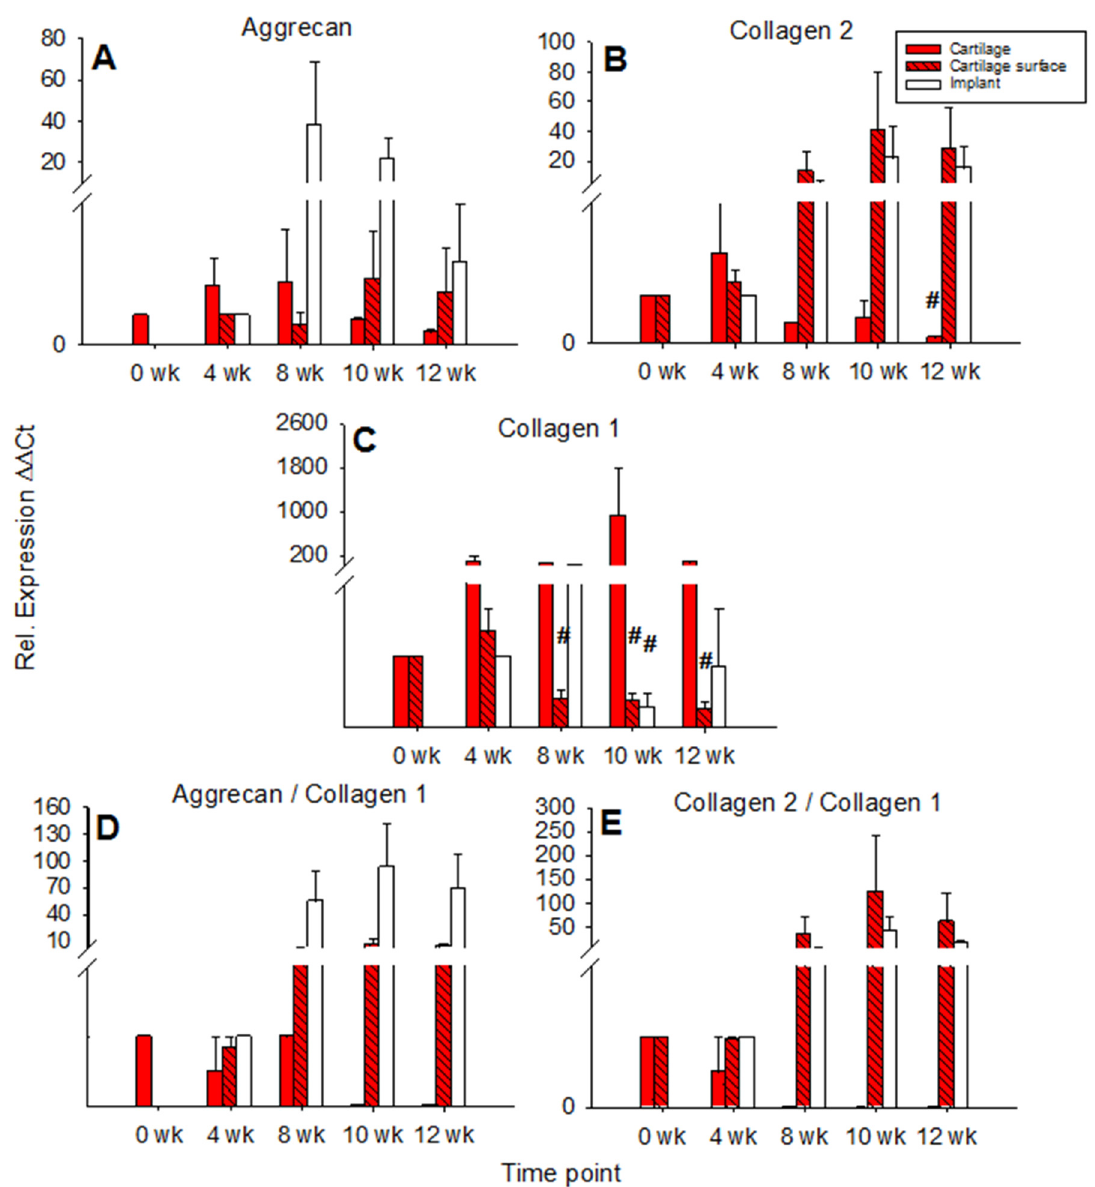
Figure 4. Real time PCR analyses for cartilage matrix proteins (cell-free PGA). mRNA levels for aggrecan ( A ), collagen 2 ( B ), collagen 1 ( C ), aggrecan/collagen 1 ratio ( D ), and collagen 2/collagen 1 ratio ( E ) were analyzed before and after 4, 8, 10, and 12 weeks of culture; relative gene expression of the chondrocytes in the cartilage matrix (cartilage), on the cartilage surface (cartilage surface), and on/in the PGA (implant); means +/ − SEM; # = p ≤ 0.05 versus 4 weeks.